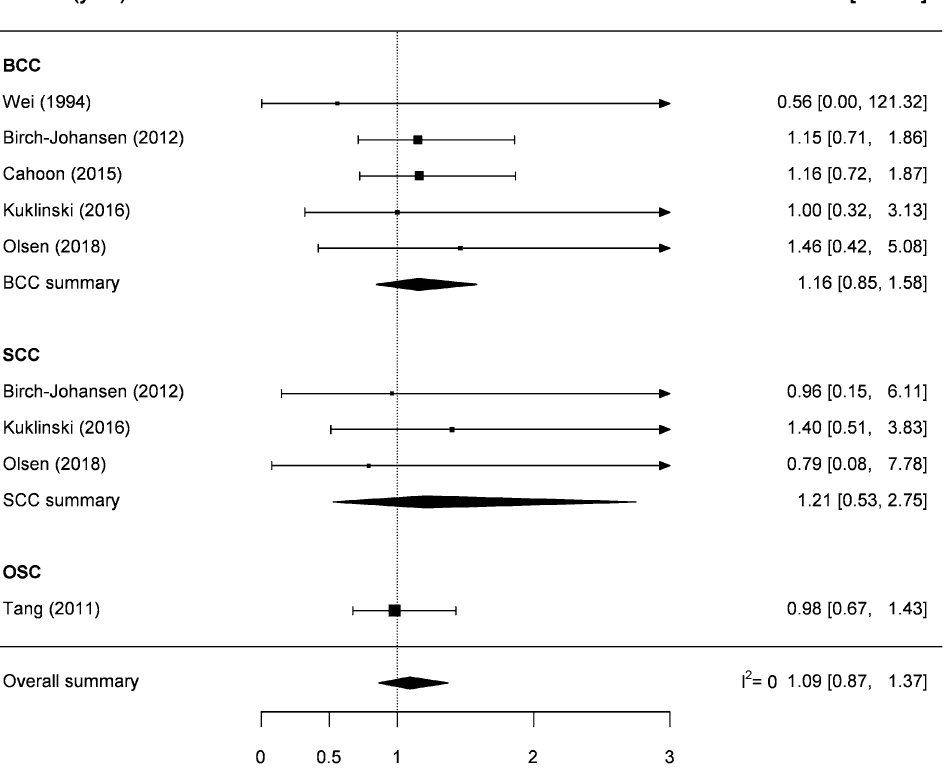
Figure 3. Forest plot for the association between use of hormone replacement therapy (ever vs. never) and the risk of non-melanoma skin cancer among women. BCC basal cell cancer, SCC squamous cell cancer, OSC other (not specified) non-melanoma skin